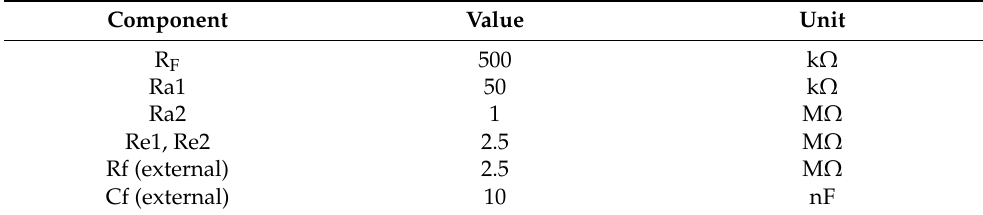
Table 19. Passive component characteristics of the integrated